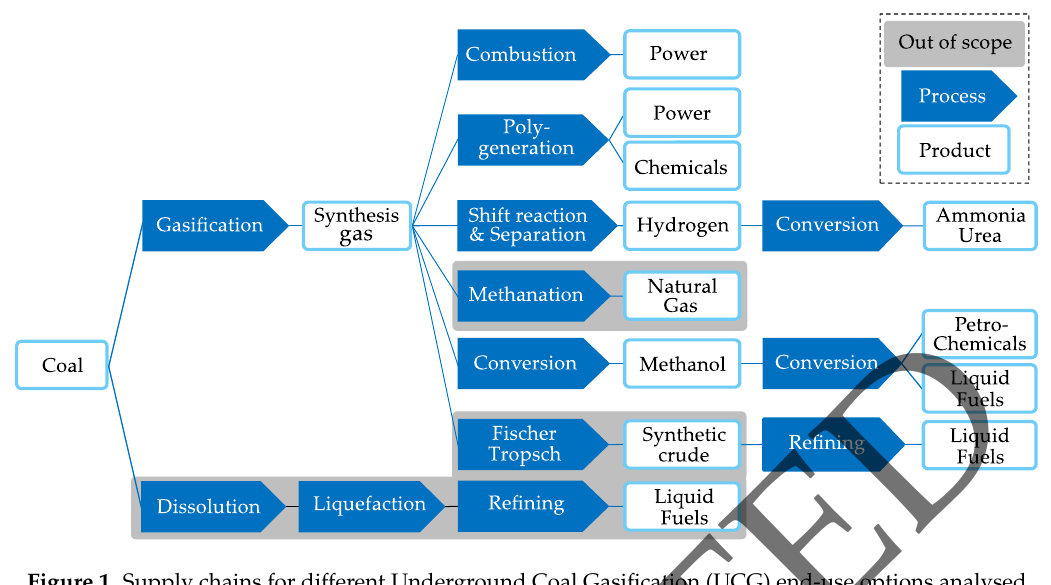
Figure 1. Supply chains for different Underground Coal Gasification (UCG) end-use options analysed within the present study (electricity generation, hydrogen production and its utilisation for methanol and ammonia synthesis), modified according to Kinaev et al. [10].